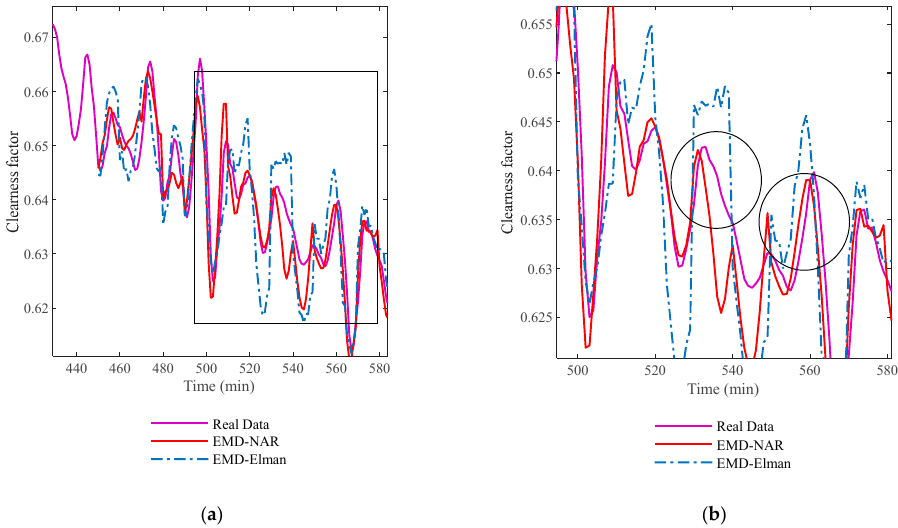
Figure 14. Using EMD to predict at different starting points. 450 min, ( a ) and partial enlarged figure ( b ).